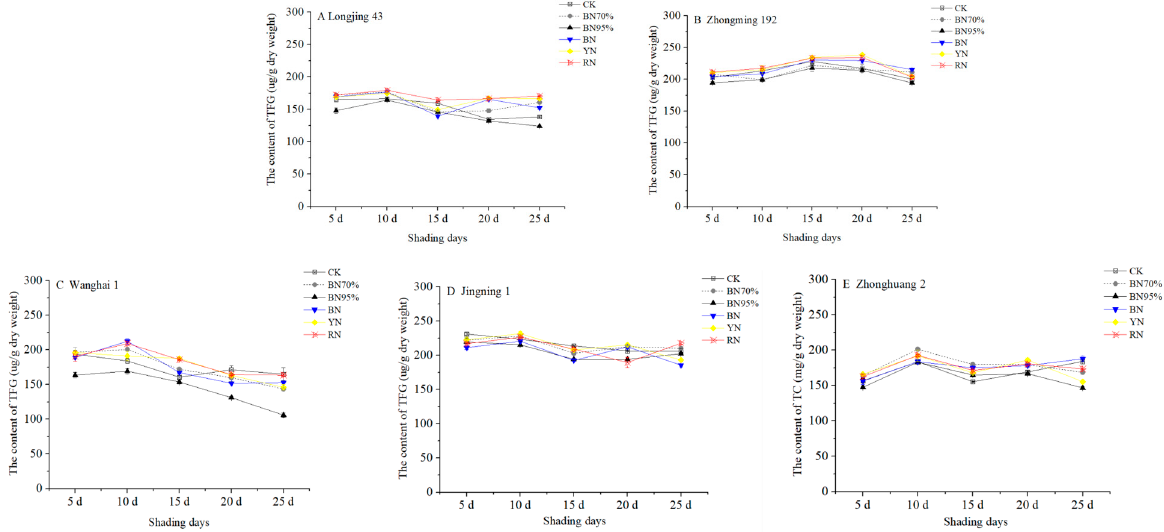
Figure 2. The impacts of shade treatments on the contents of total catechins in the young shoots of different tea cultivars. TC: total catechins. Significantly different results are shown in Table S1.